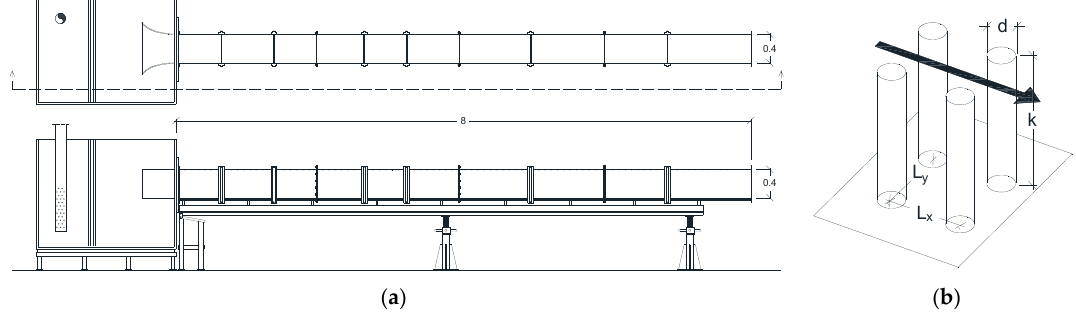
Figure 1. ( a ) Experimental facility. The laboratory flume was 8 m long with a 0.4 m wide and 0.4 m deep rectangular cross-section. The bed of the flume was uniformly covered by an array of rigid cylinders. ( b ) Geometry of the array of aligned cylinders and specification of diameter ( d ), spacing ( L x and L y ), and cylinder height ( k ).